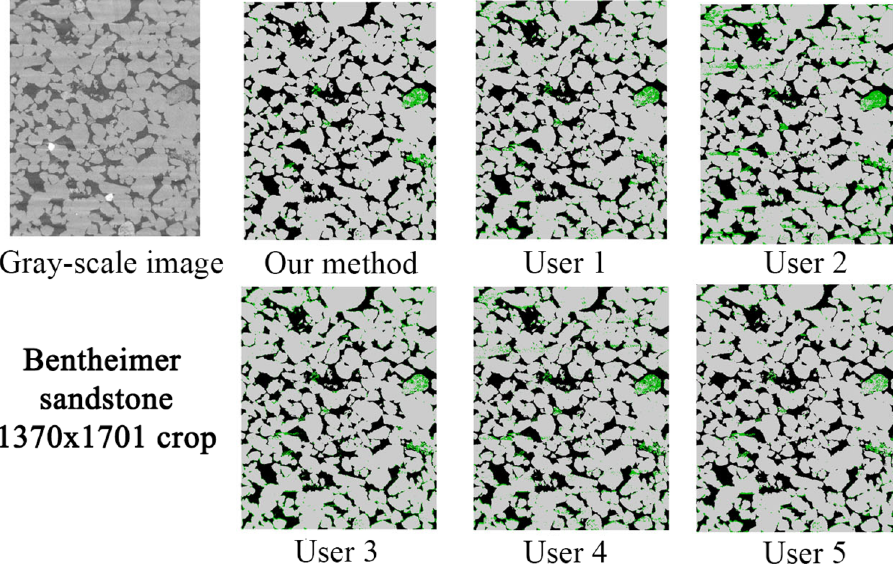
Figure 10. Comparison of segmentation results on a vertical full-size crop of the Bentheimer image. A significant level of noise in the form of stripes that span the width of the image, together with beam hardening can be seen in the bottom of the gray-image crop.